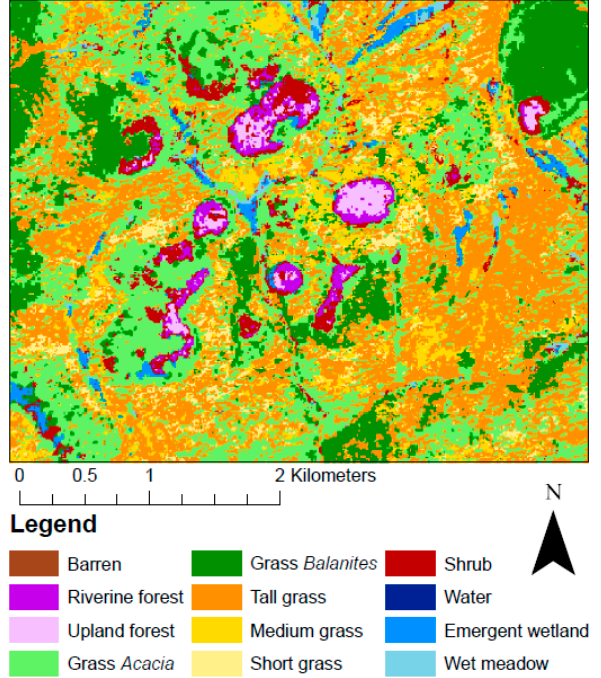
Figure 6. A cluster of inselbergs in the southwestern Mara Triangle, on which rock and dense woody vegetation occur.